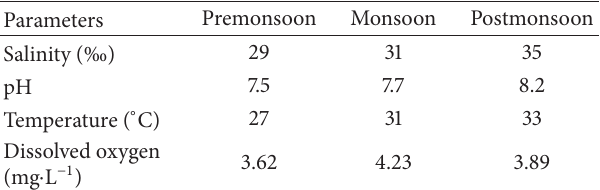
Table 5: Physicochemical properties of the water in the